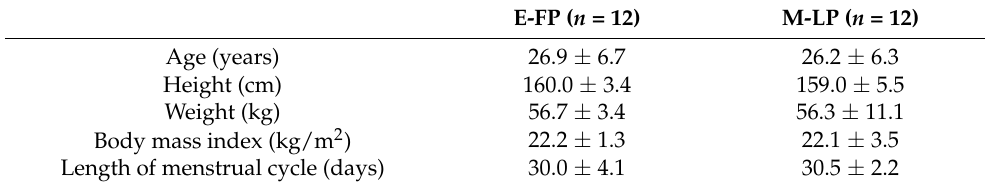
Table 1. Participant